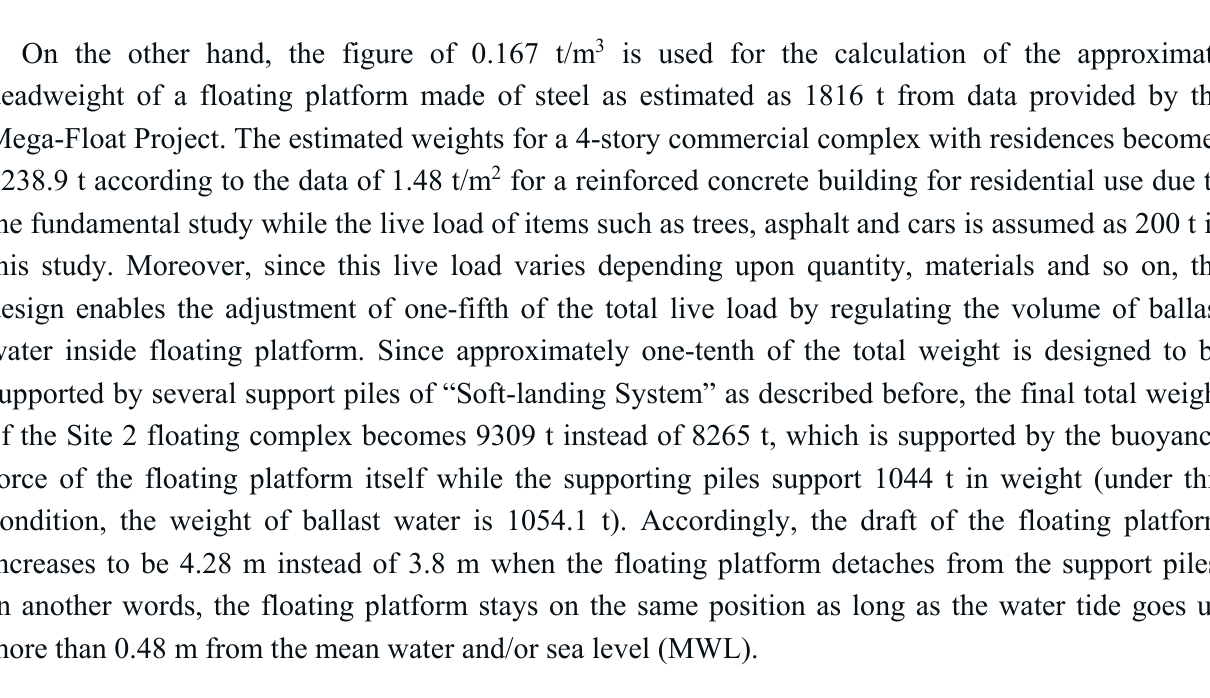
Figure 18. Bird’s-eye view of the Site 2 floating complex (Image as represented by architectural